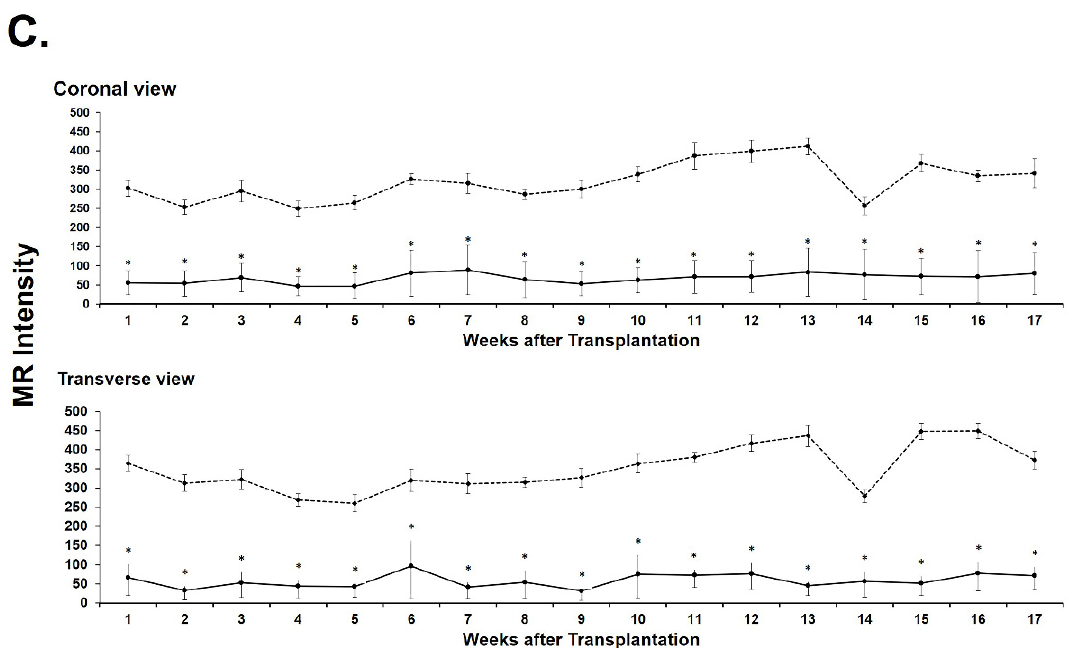
Figure 9. Seventeen-week in vivo MR images of the MnMEIO-Ex4 NPs-labeled islet graft. Seven hundred MnMEIO-Ex4 NPs-labeled islets were transplanted under the left kidney capsule of a C57BL/6 mouse. The recipient was scanned by a 7.0 T MRI system with transverse ( A ) and coronal ( B ) sections for 17 weeks. The graft on MR images was indicated by arrows. ( C ) Time course of the MR signal intensity of the graft on left kidney (solid line) and the mirror area on the right kidney (dash line) in the mouse transplanted with 600 MnMEIO-Ex4 NPs-labeled islets. * p = 0.000.